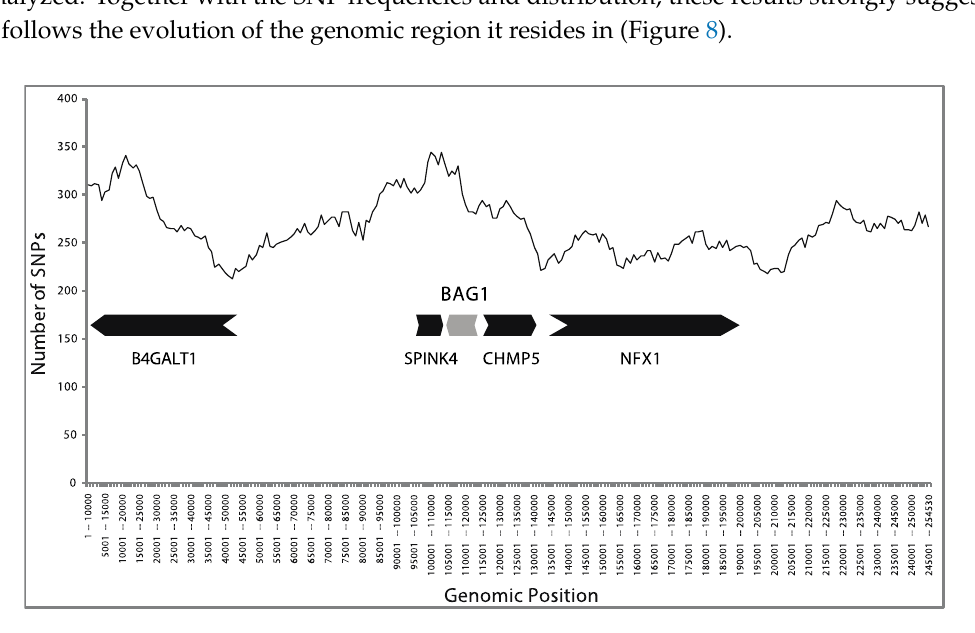
Figure 8. Distribution of the total SNP number of the BAG1 locus genomic region. The plot was generated with an in—house script that plots the total number of SNPs in a window of 10,000 using a 1000 step size. The boxes represent the gene loci found in the 200-Kb region: B4GALT1 , SPINK4 , BAG1 , CHMP5 , NFX1 .